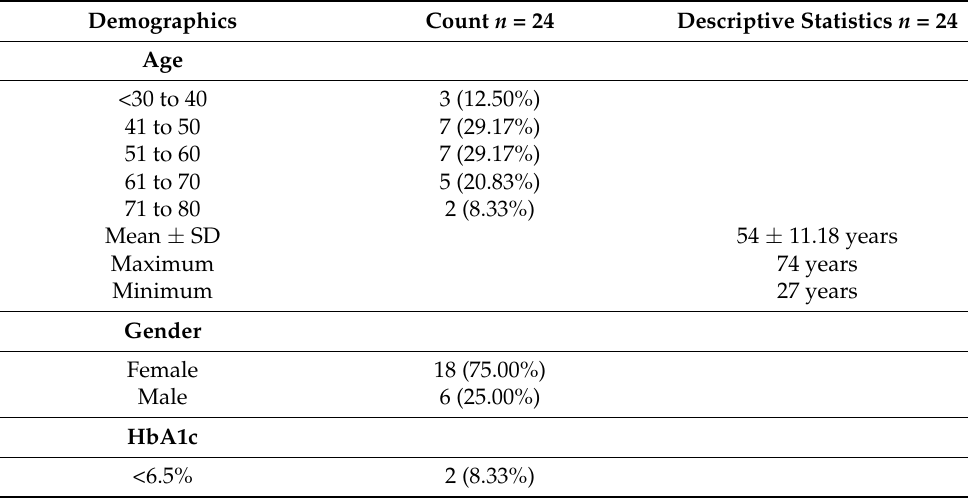
Table 2. Demographic characteristics of eligible